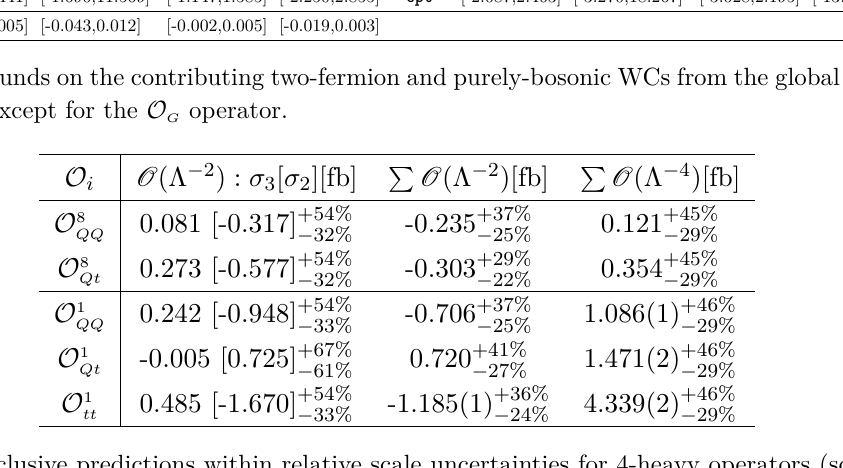
Table 8 . Inclusive predictions within relative scale uncertainties for 4-heavy operators (scales are given on σ 3 in the first column). P O (Λ − 2 ) and P O (Λ − 4 ) indicate total linear interference and total quadratic contributions,